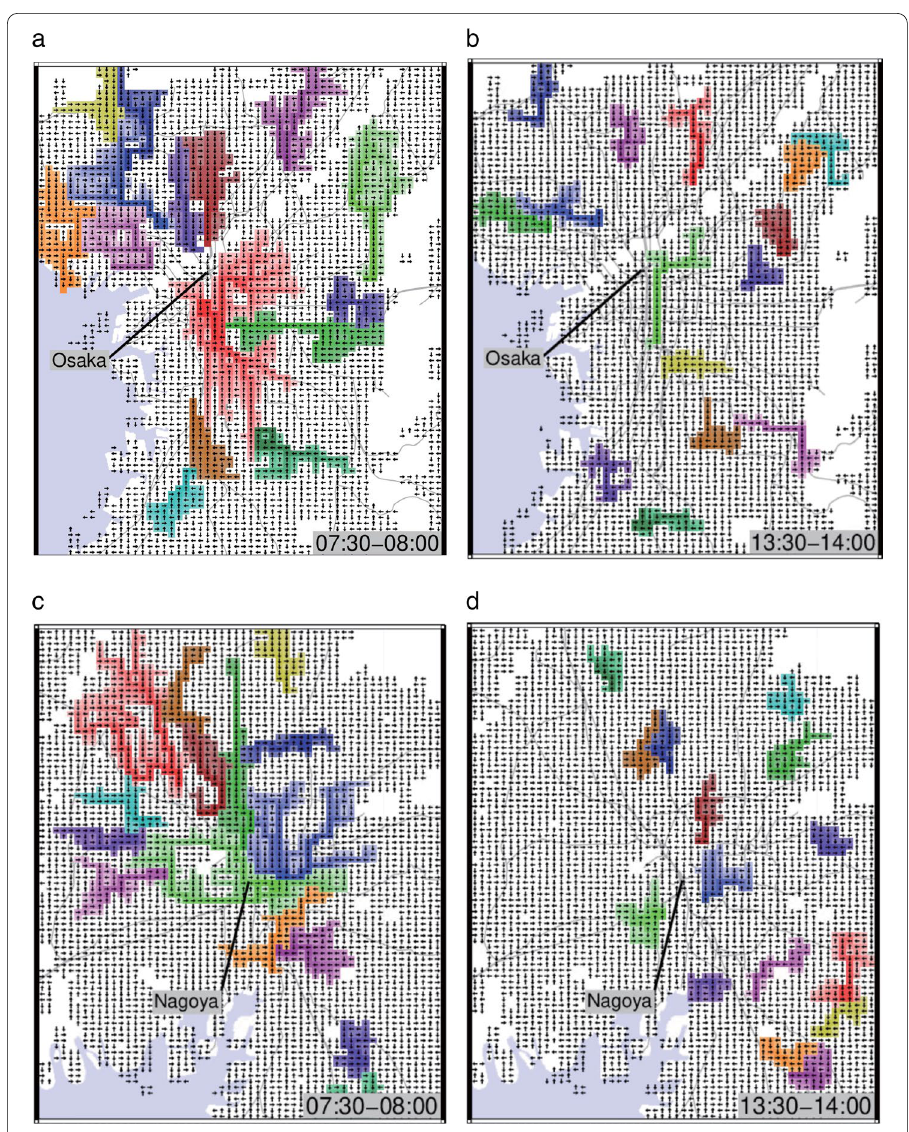
Fig. 6 Drainage basins around Osaka and Nagoya metropolitan area during COVID-19 pandemic. a , b , Flow maps of basins in a the morning commuter rush hour (07:30–08:00) and b the afternoon (13:30–14:00) in the Osaka metropolitan area, where the largest 15 basins are shown in different color codes. The display area is about 20–30 km square. c – d , Flow maps of basins in a the morning commuter rush hour (07:30–08:00) and b the afternoon (13:30–14:00) in the Nagoya metropolitan area, where the largest 15 basins are shown in different color codes. The display area is about 20–30 km